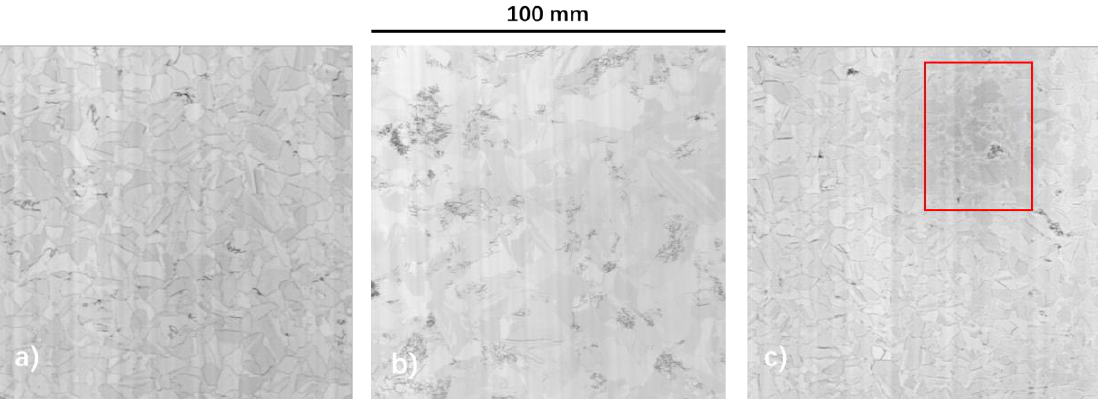
Figure 5. PL images of Mc-Si bottom wafers assisted by ( a ) electrophoretic deposited quartz powder, ( b ) spray quartz powder, and ( c ) silicon particles.